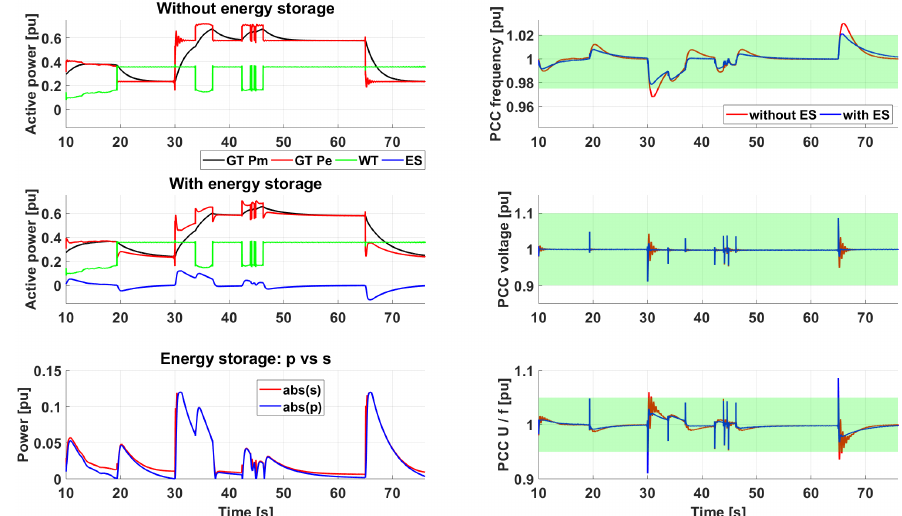
Figure 4. Active power, ESS active (p) versus apparent (s) power, PCC frequency and voltage for 10 < t < 76